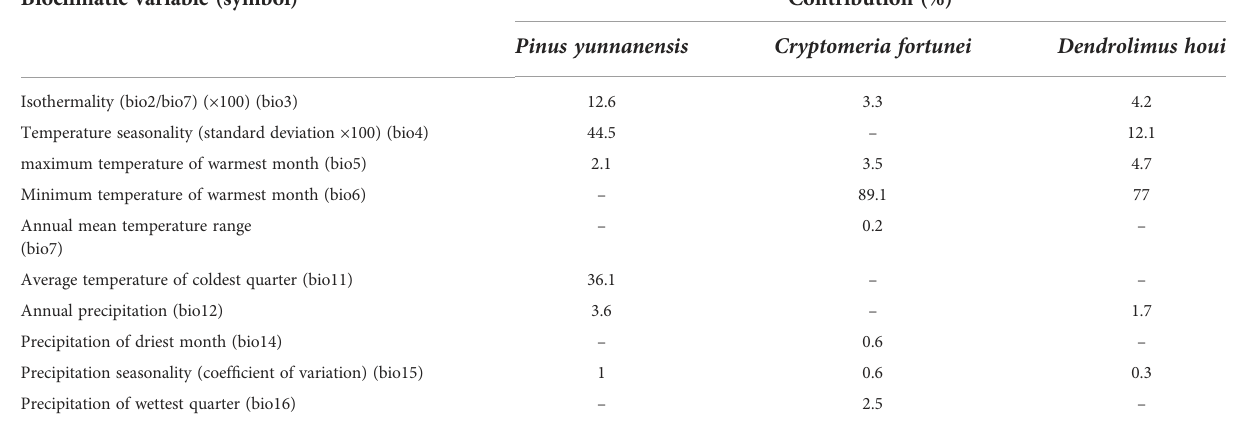
TABLE 2 Climatic variables selected by the MaxEnt model.